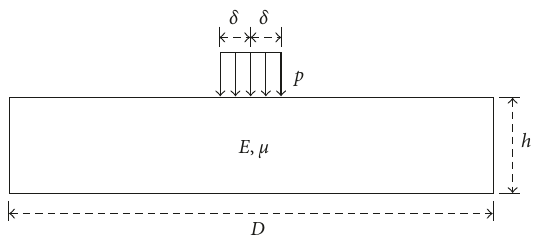
Figure 1: Sketch of the test model of pavement